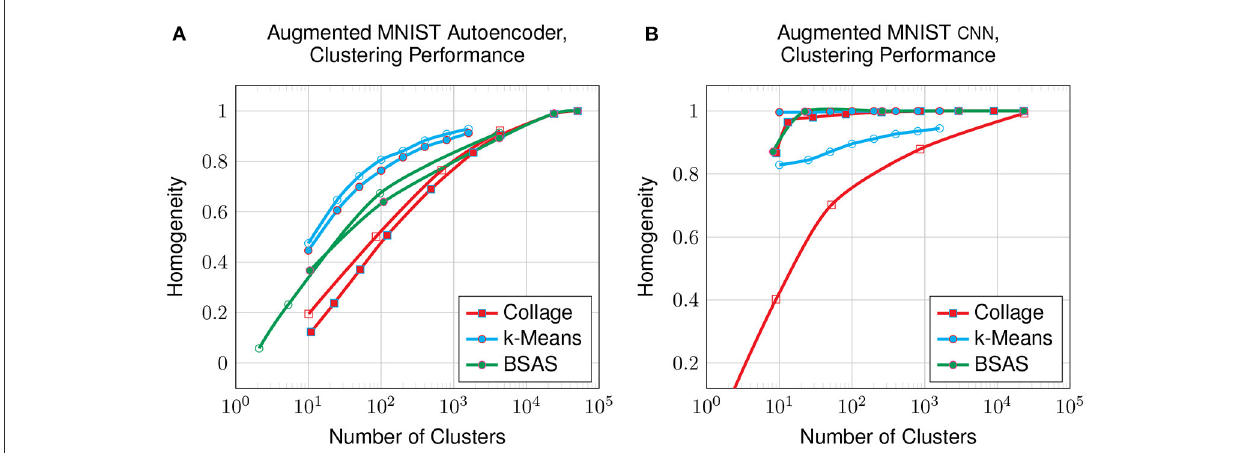
FIGURE11 Clustering on the latent-encoded, augmented MNIST dataset: homogeneity compared to the number of clusters on all clustering algorithms from an autoencoder (A) and from a CNN (B) . Solid datapoints are from the original dataset; hollow datapoints are from the augmented